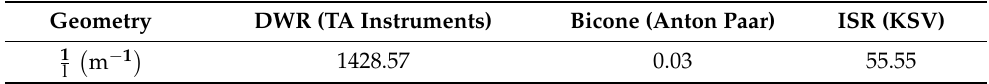
Table 1. Geometrical ratios of interfacial shear geometries.